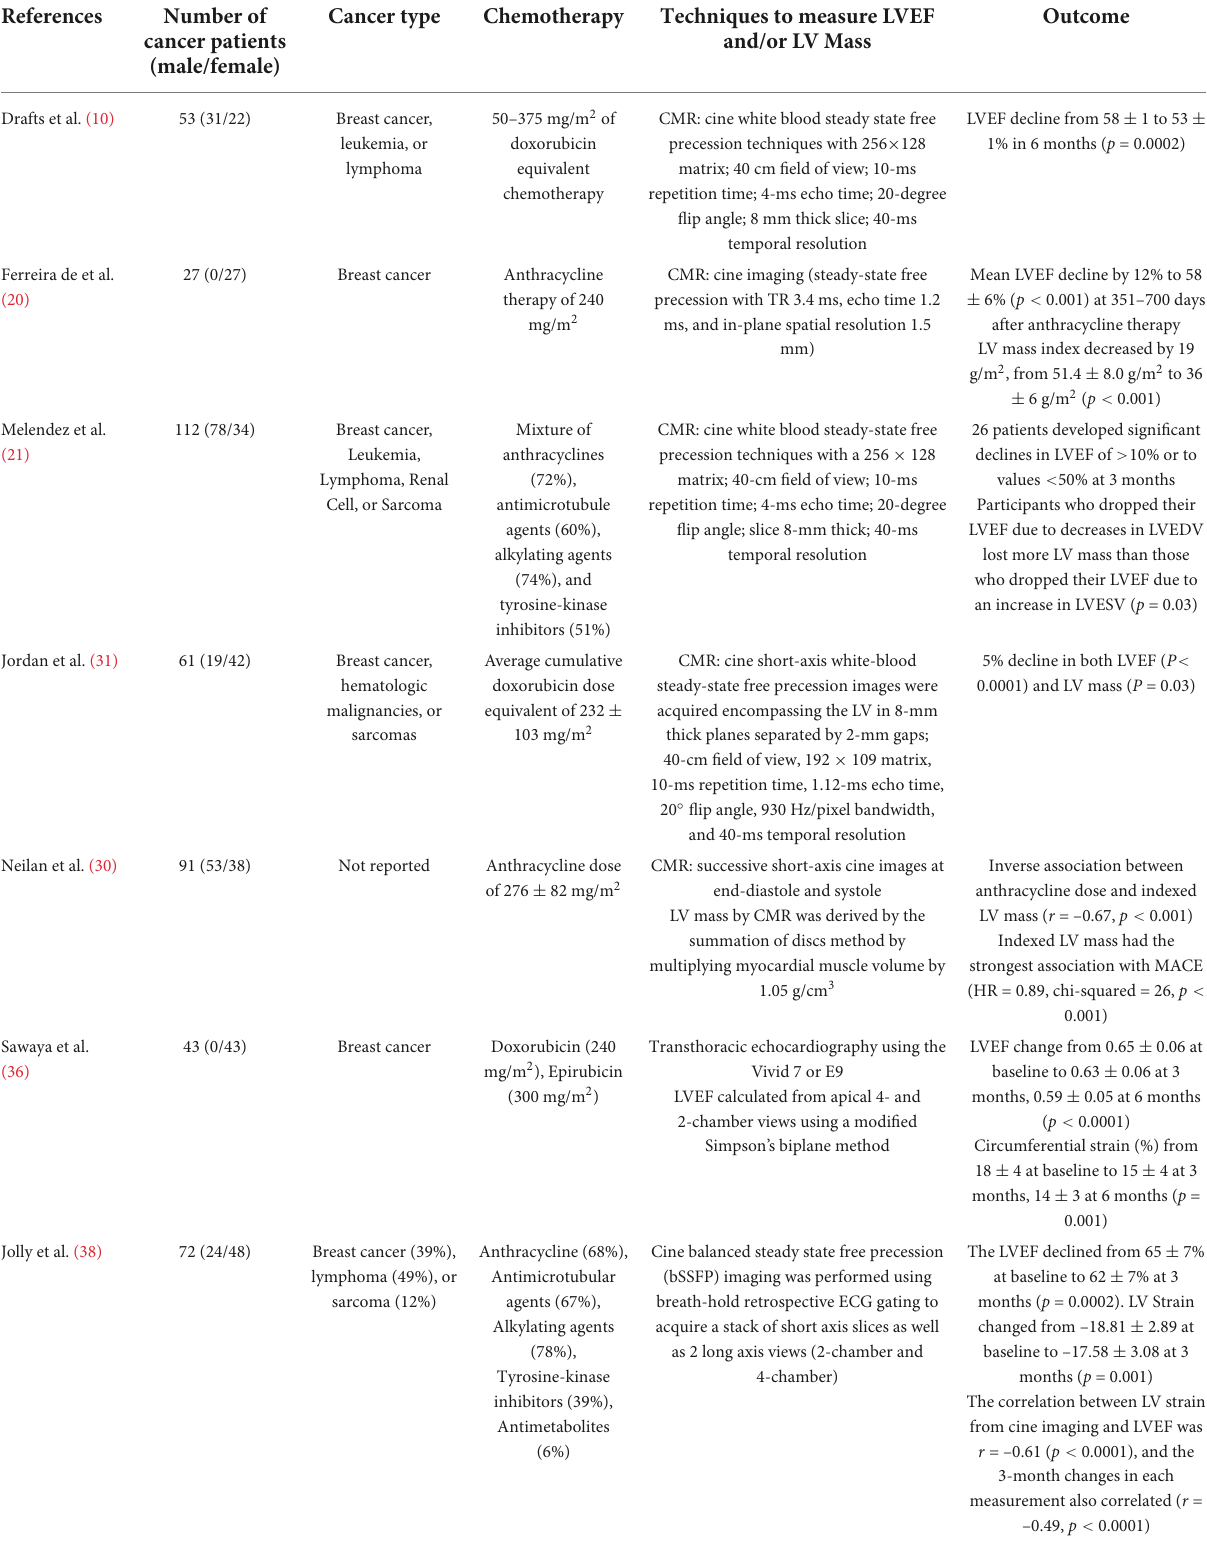
TABLE 1 Summarizes the number of cancer patients, cancer type, chemotherapy, techniques to measure LVEF and/or LV mass, and the outcome of each study cited in this